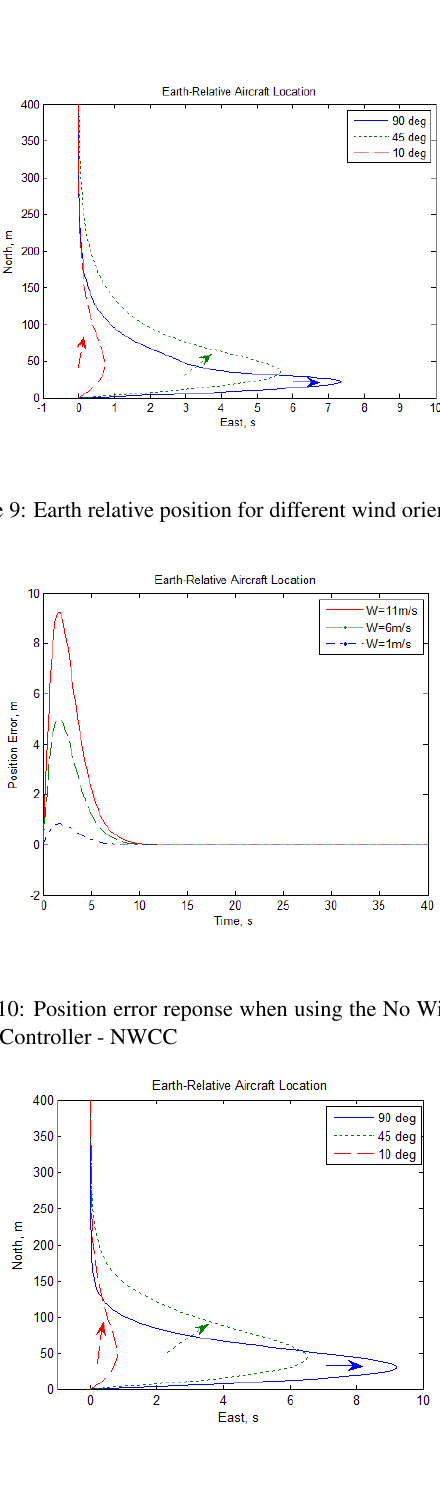
Figure 11: Earth relative position for different wind orientation